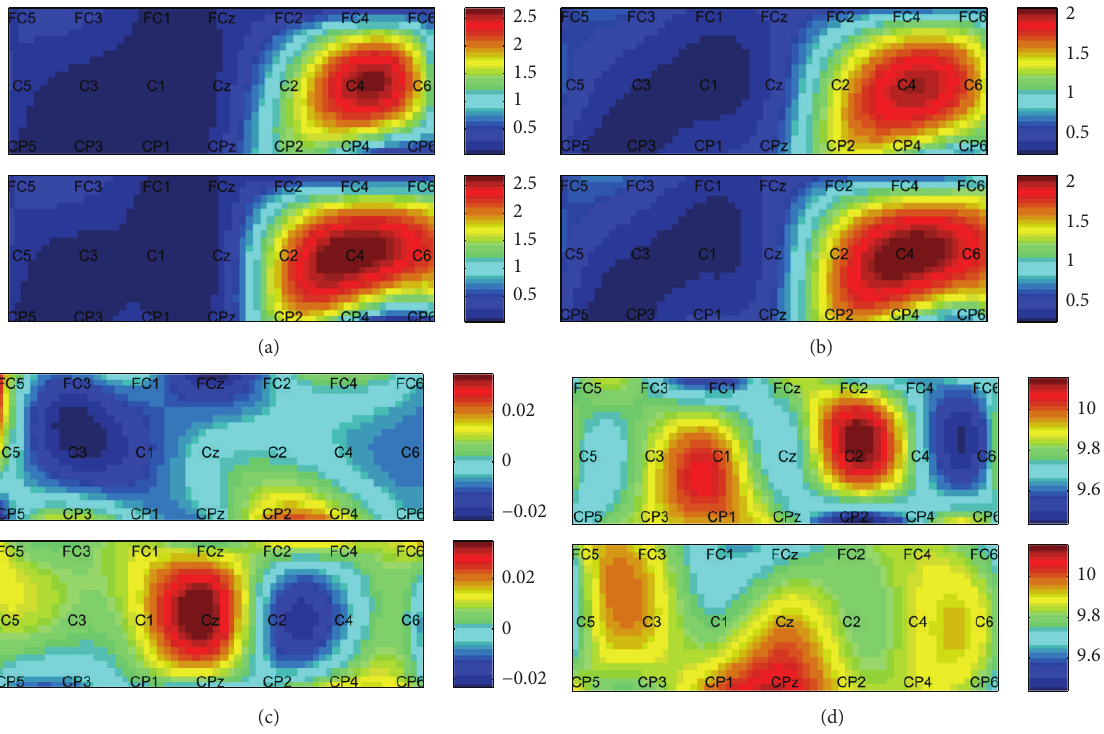
Figure 3: The topography of four different mu feature types of a subject session. The mean feature value during [0 0.5] period is used for the plot. (a) The topography of power. (b) The topography of the instantaneous amplitude (IA). (c) The topography of the instantaneous phase (IP). (d) The topography of the instantaneous frequency